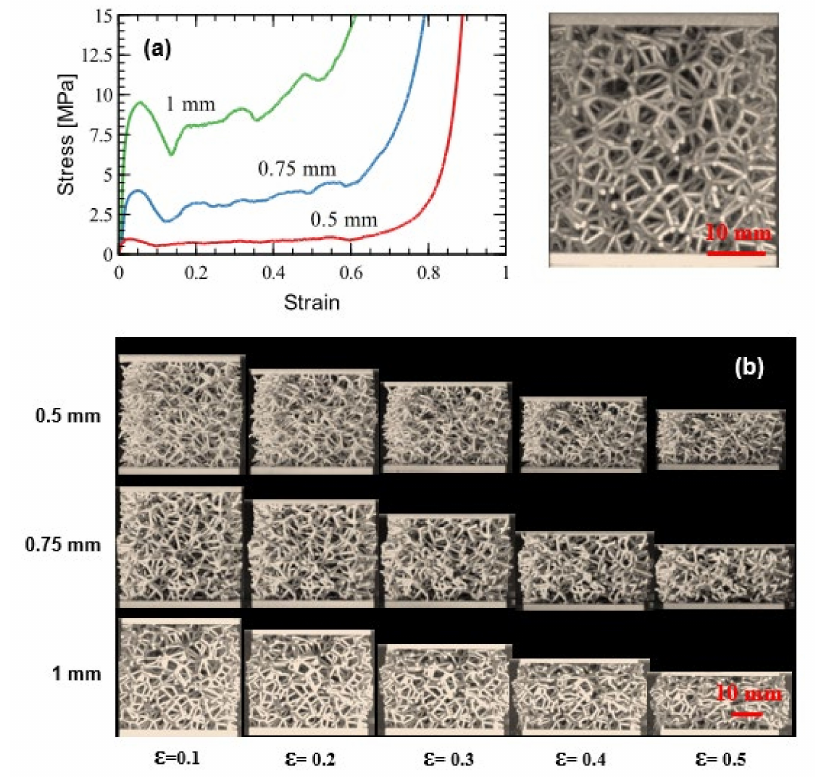
Figure 10. ( a ) Stress–strain curves for Voronoi lattice shape under compression with 0.5, 0.75 and 1 mm beam diameters, and ( b ) Voronoi lattice deformation sequence for each of the three beam diameter specimens at increasing strain.